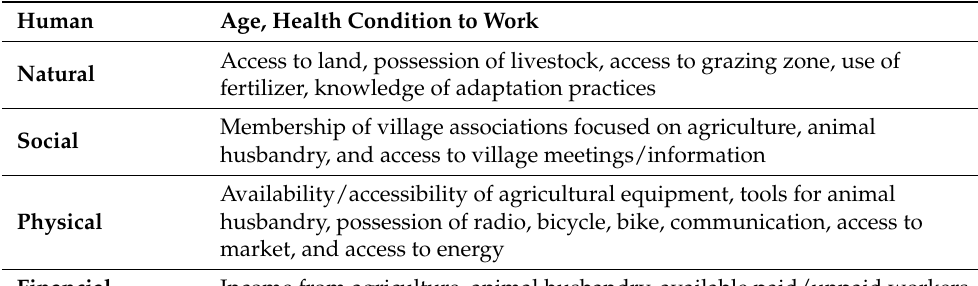
Table 1. Criteria for evaluating five SLA